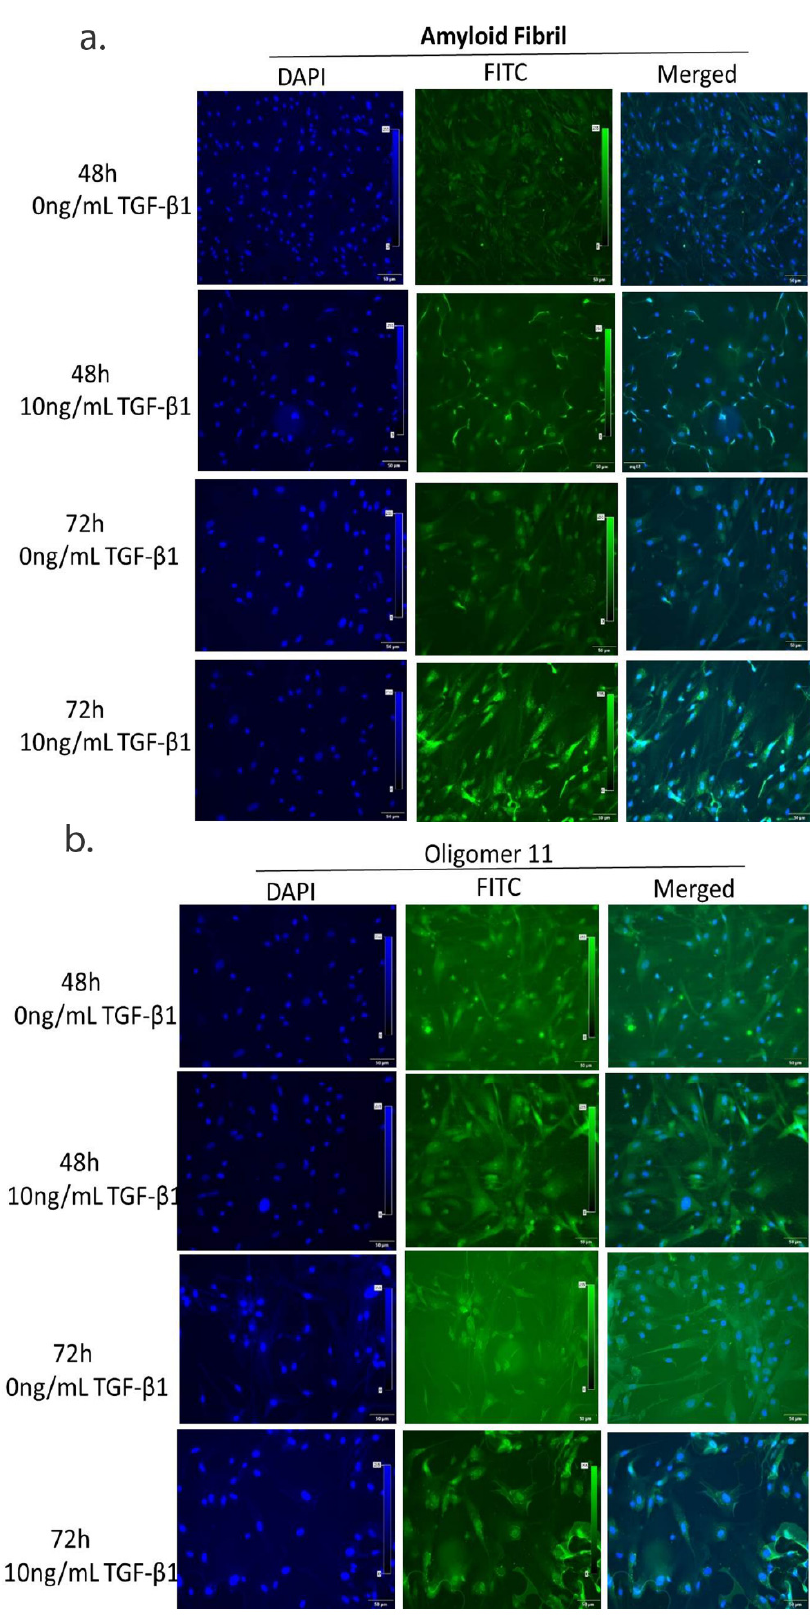
Figure 4. TGF- β 1 causes fibrillar aggregates in TM cells . Immunofluorescence images of protein aggregates. Misfolded protein in cultured TM cells after TGF- β 1 (10 ng/mL) treatment for 48 h and 72 h stained with ( a ) Amyloid fibril antibody, ( b ) oligomer 11 antibody (at 20 × magnification). Bar = 50 µ